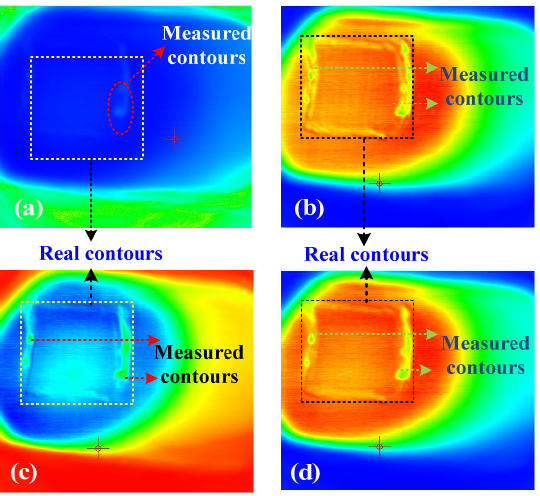
Figure 21. Top-view of time-domain THz images of the testing sample under different modes [75]. ( a ) Absorption spectrum imaging at 0.476 THz; ( b ) Maximum-peak imaging; ( c ) Minimum-peak imaging; ( d ) Peak-peak imaging.At the same time, this delamination also leads to moisture intrusion, causing the insulation of the cable to deteriorate with moisture and form water dendrites. After